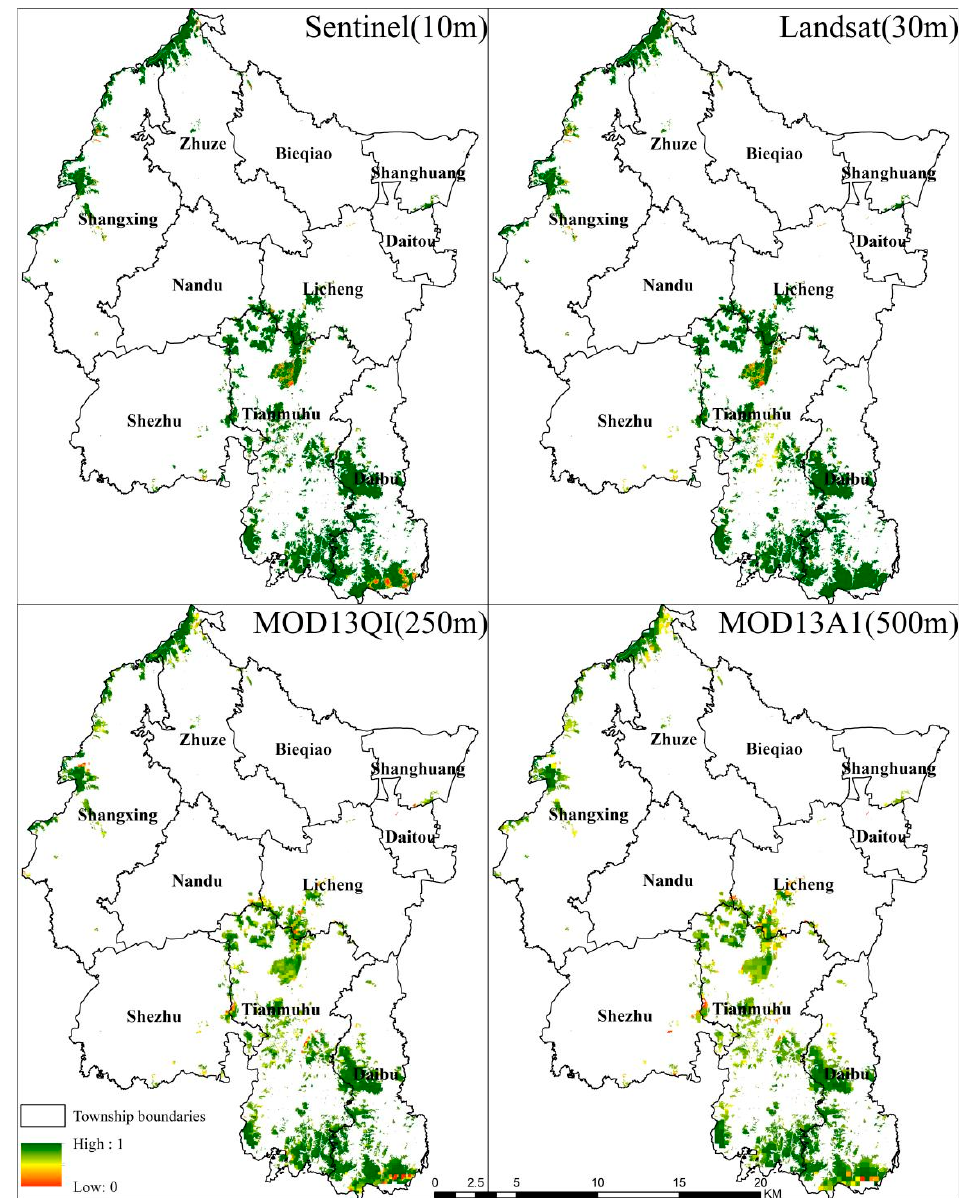
Figure 3. Woodland FVC distribution maps extracted from images with four different spatial reso- lutions.